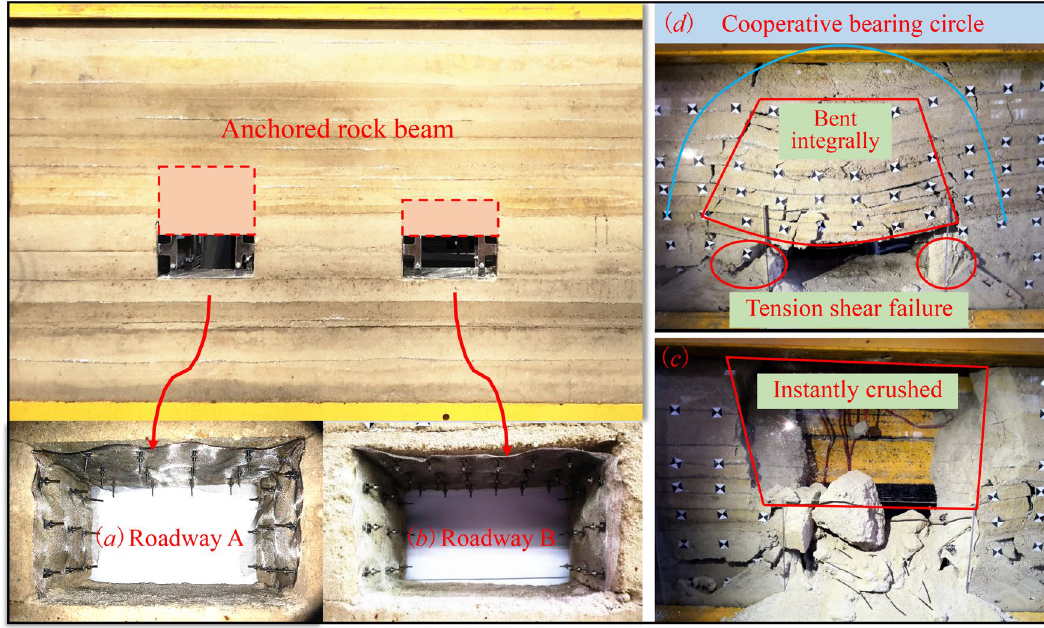
Figure 21. Roadway failure characteristics based on similarity model and impact dynamic